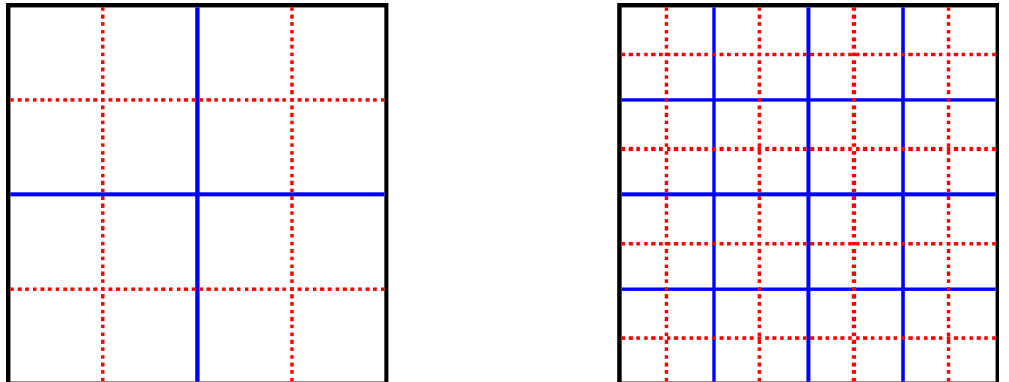
Figure 2. Original (blue, solid line) and alternate (red, dotted line) division of a 2 n ext × 2 n ext image into blocks for resolution levels r = 2 (left image) and r = 3 (right